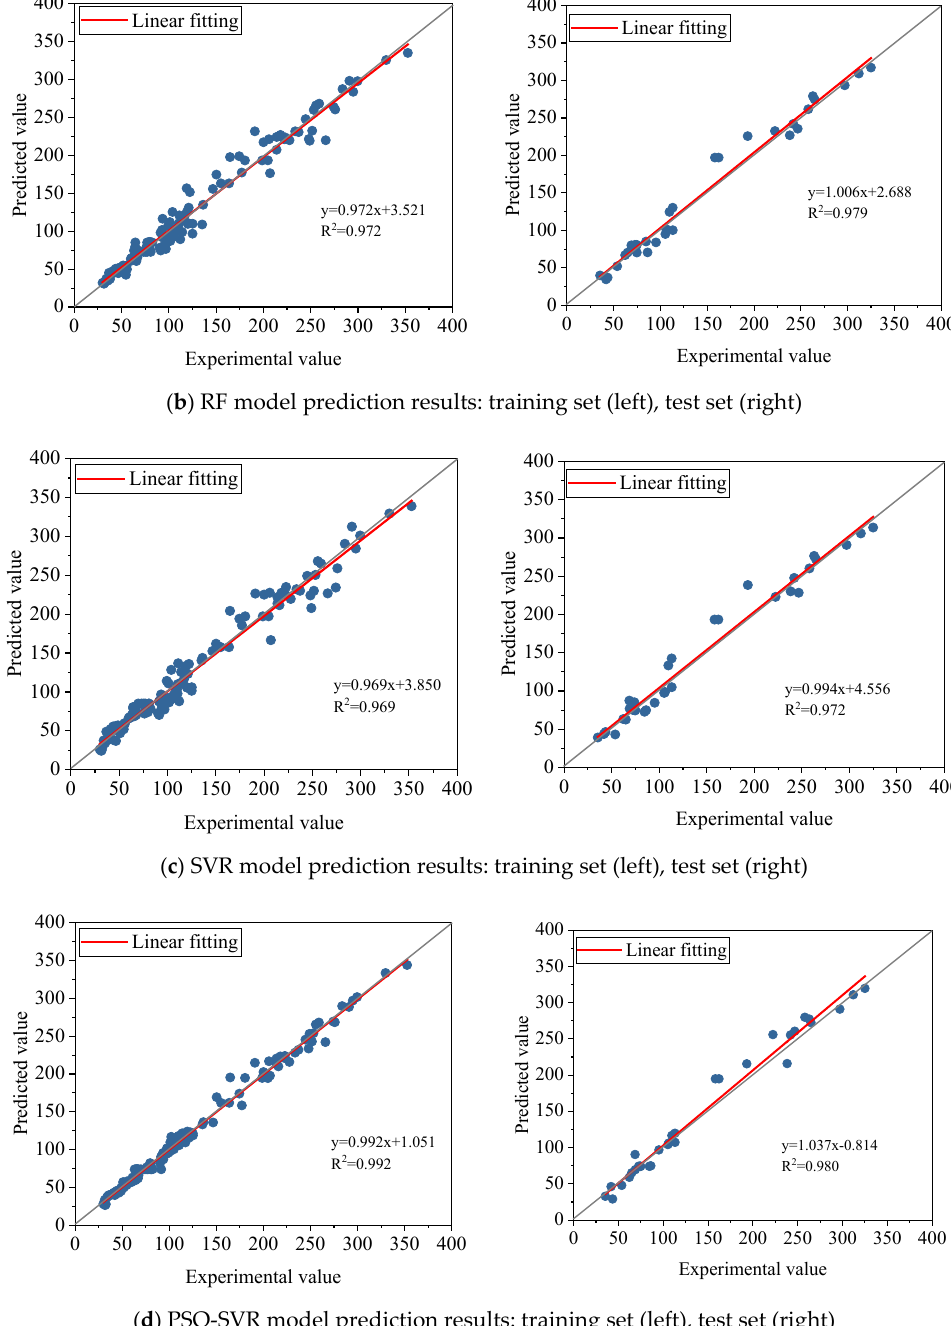
( d ) PSO-SVR model prediction results: training set (left), test set (right) Figure 5. Prediction results of three models. ( a ) ELM model prediction results; ( b ) RF model prediction results; ( c ) SVR model prediction results; ( d ) PSO-SVR model prediction results. The box line plots of the relative prediction errors for the testing samples are shown in Figure 6. Compared with the ELM model, the mean prediction relative errors of the other three models were within 10%. For the PSO-SVR model, the mean value of the pre- diction error reached a minimum of 7.944%. To facilitate further comparison of the pre- diction performance of different models, Table 3 lists the evaluation metrics for the train- ing and testing phases of each model. For the PSO-SVR model, the correlation coefficient R 2 is the highest and is close to 1. The other two error metrics are smaller than the other